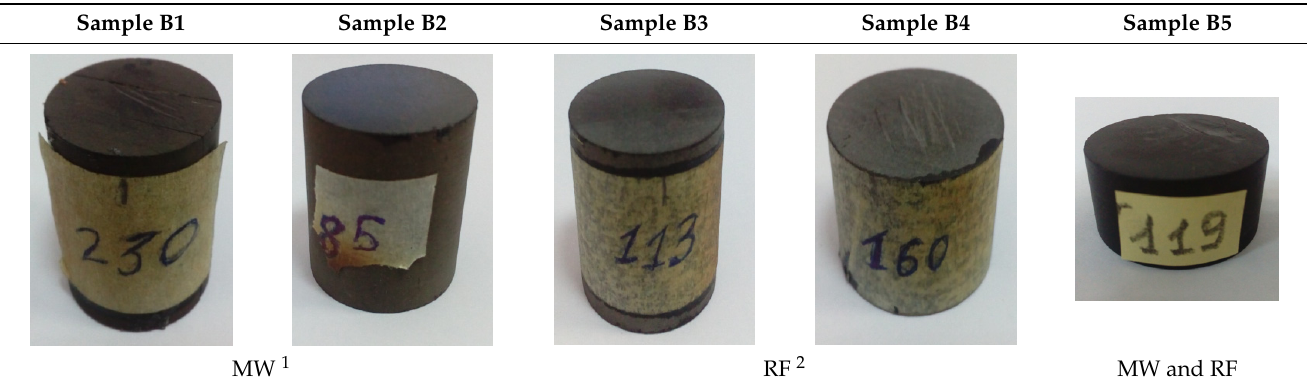
Table 2. The photos of the Domanic Formation samples and type of electromagnetic treatment exposed in the experiments.